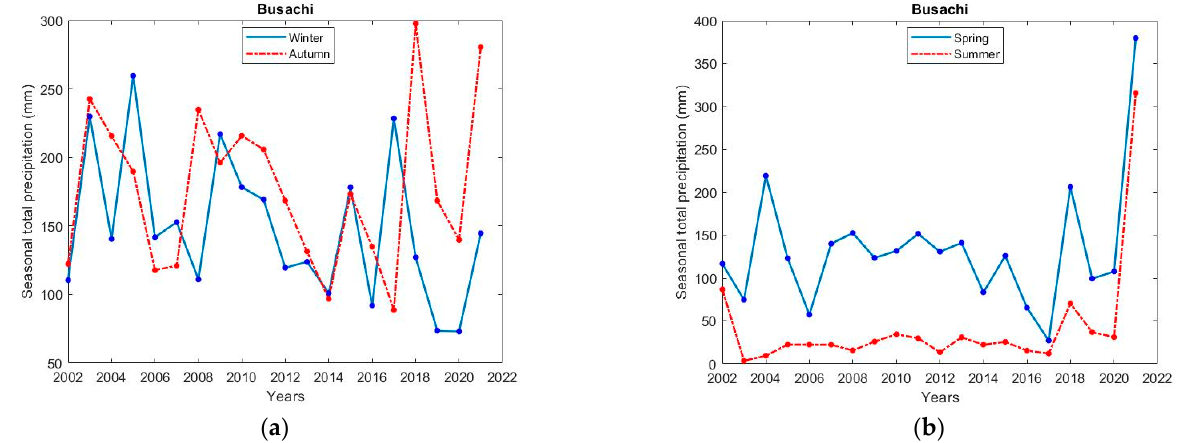
Figure 7. Seasonal cumulative precipitation trends: ( a ) in winter and autumn, ( b ) in spring and summer, for the Busachi case study.